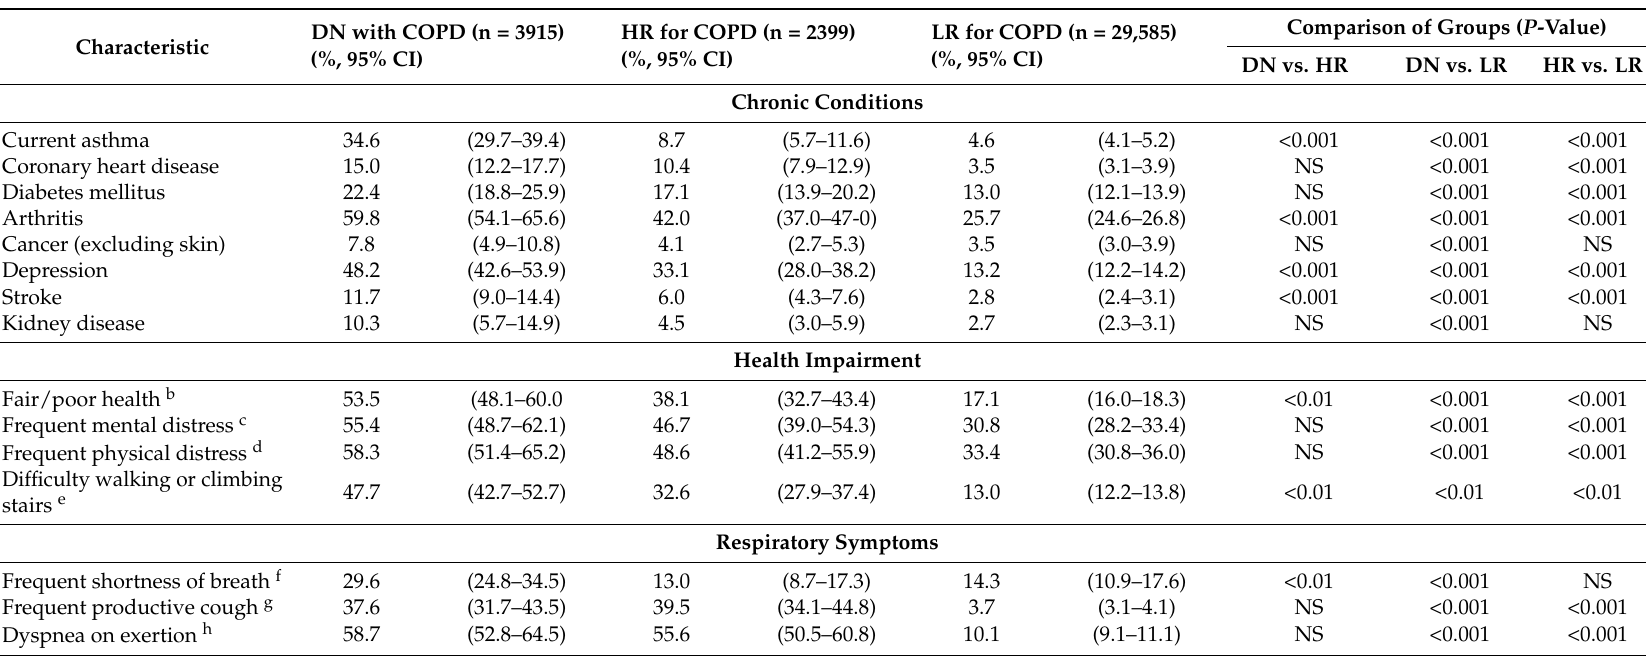
Table 3. Age adjusted prevalence and 95% confidence intervals (95% CI) of health characteristics and respiratory symptoms in adults aged ≥ 18 years by COPD risk status a —BRFSS, 2015 among four states (FL, KY, SC,